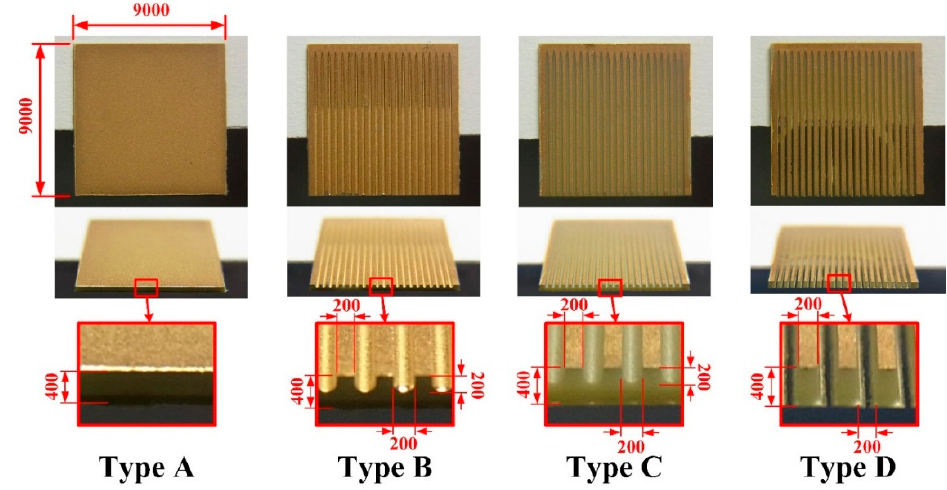
Figure 5. Fabricated PZT pyroelectric cells with various structures (unit: μ m).